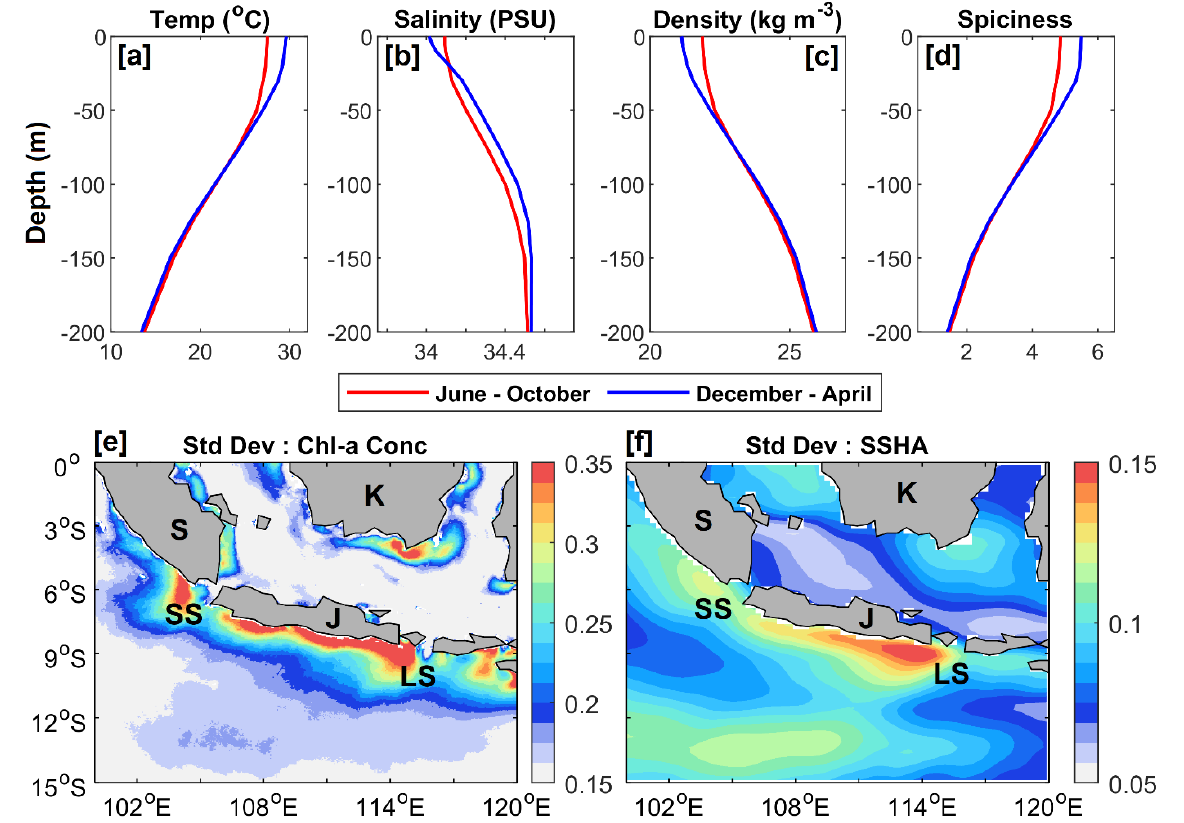
Figure 2. The region averaged seasonal profiles of ( a ) temperature (in °C), ( b ) salinity (in PSU), ( c ) density (in kg m −3 ) and ( d ) spiciness from Argo datasets during the June − October (red) and December–April (blue) along the Java coast. Spatial standard deviation map of ( e ) surface chlorophyll-a concentration (in mg m − 3 ) and ( f ) sea surface height anomaly (SSHA in m) during 2008–2019 along the Java coast. S, J, K, SS and LS denote Sumatra, Java, Kalimantan, Sunda Strait and Lombok Strait.